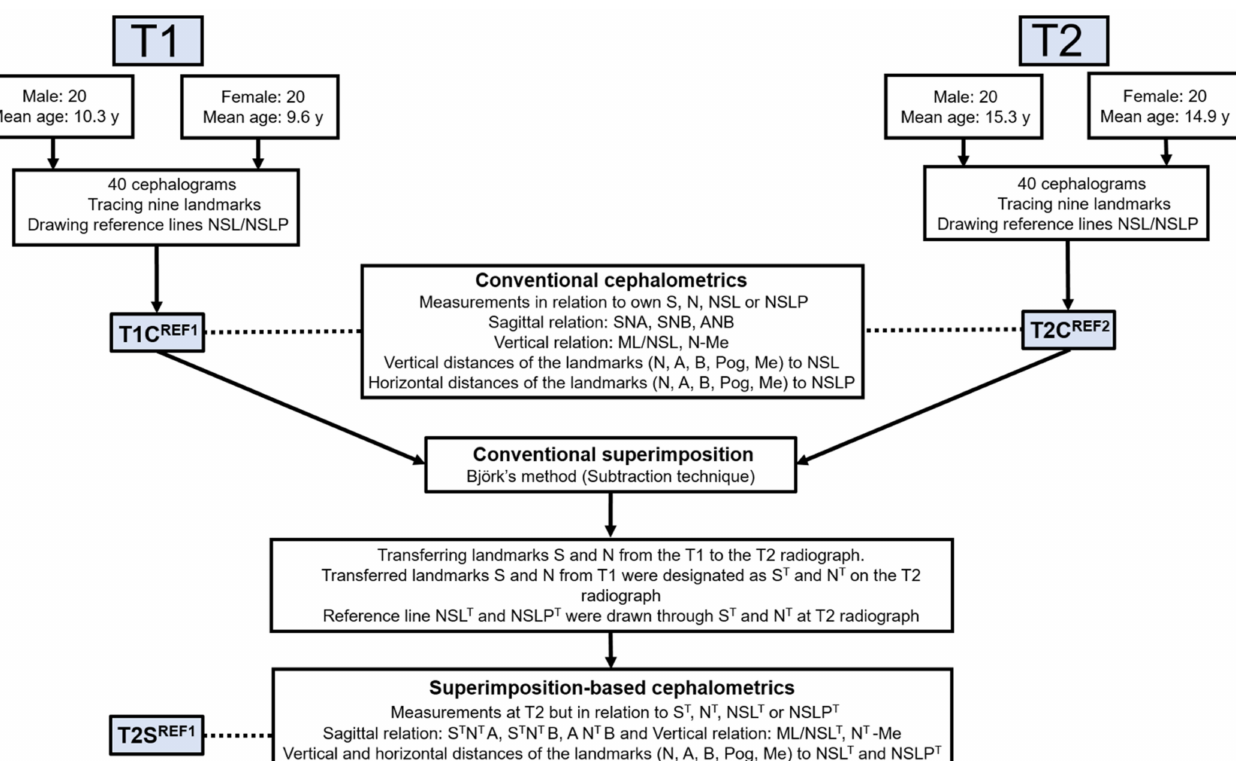
Figure A1. Workflow for the superimposition-based cephalometrics (new